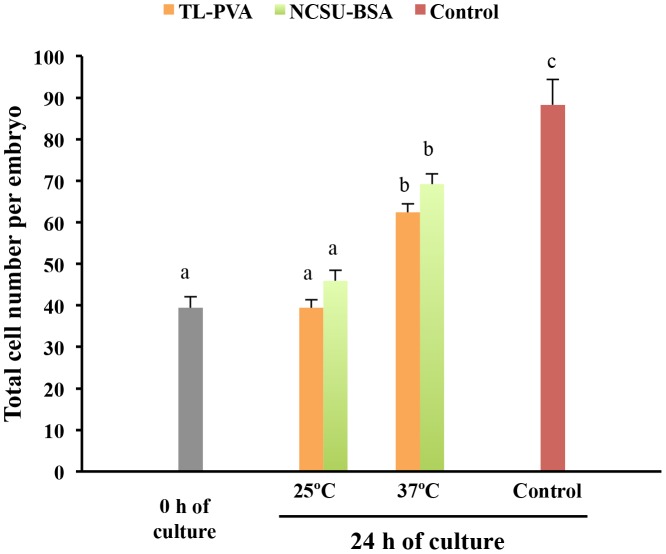
Total cell number (means ± S.E.M.) of in vivo-derived morulae cultured for 24 h under different temperatures and media.Morulae were cultured in closed Eppendorf tubes containing 1.5 mL of TL-PVA or NCSU23-BSA media, supplemented with 10 mM HEPES, at 25°C or 37°C. Controls were morulae cultured in 4-well multi-dish plates, with each well containing 500 µL of NCSU-23 medium supplemented with BSA and fetal calf serum, at 38.5°C in humidified air with 5% CO2.Different letters represent differences (p<0.001) among groups.